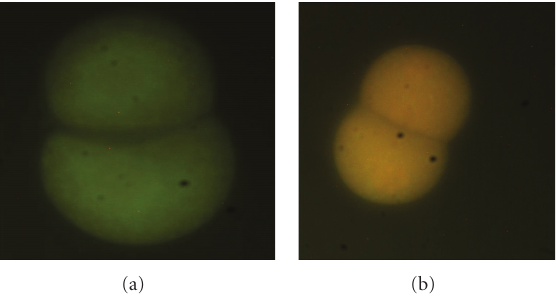
Figure 2: Two-cell embryo with green fluorescence (a) and two-cell embryo without green fluorescence (b) 24 hours after insemination (arrows).